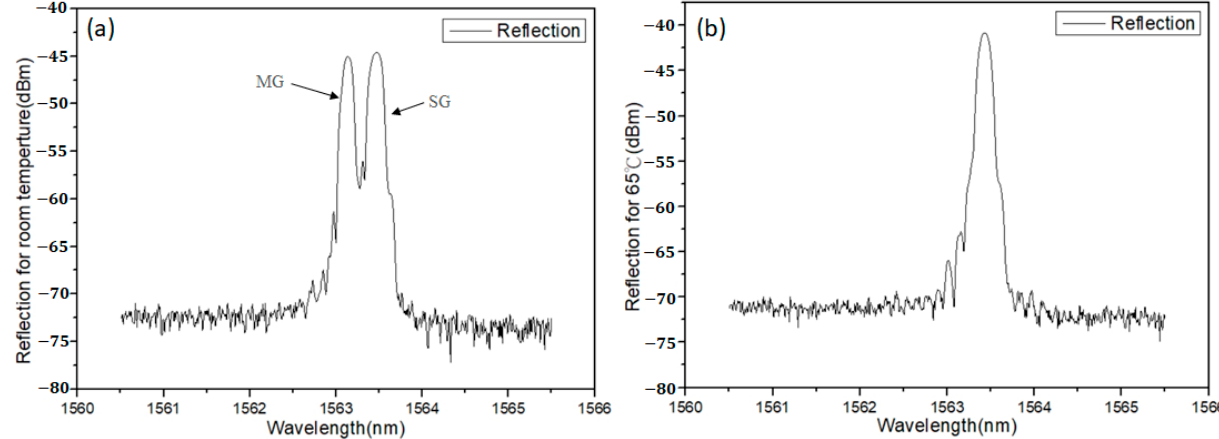
Figure 3. The reflection spectrum from both the SG and the MG. ( a ) The reflection spectrum at 25 ◦ C ; ( b ) the reflection spectrum of FBG sensor when the MG was baked to 65 ◦ C to match the peak from the SG.